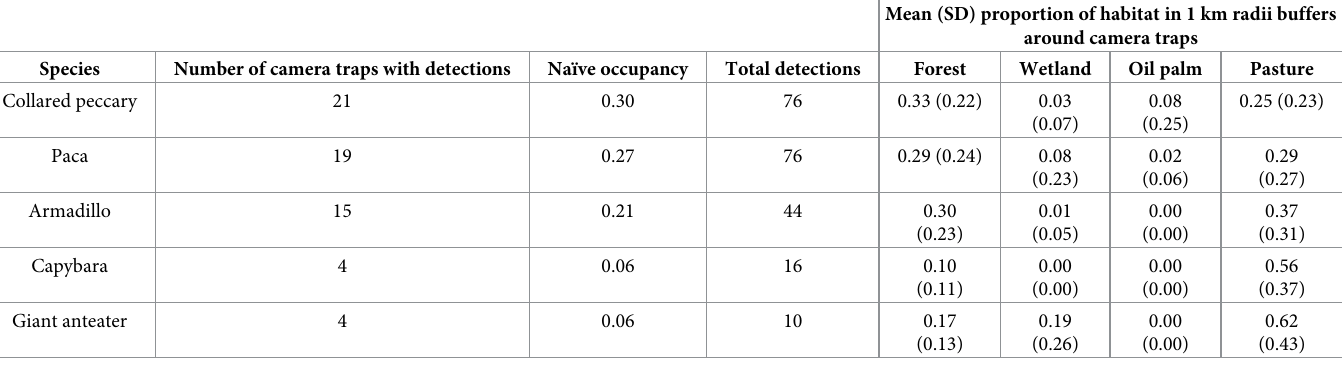
Table 5. Summary of prey detections. Prey detections by habitat type and mean values of habitat covariates in 1 km radii buffers at camera trap sites (n = 70) in the mid- dle Magdalena River valley, Colombia.